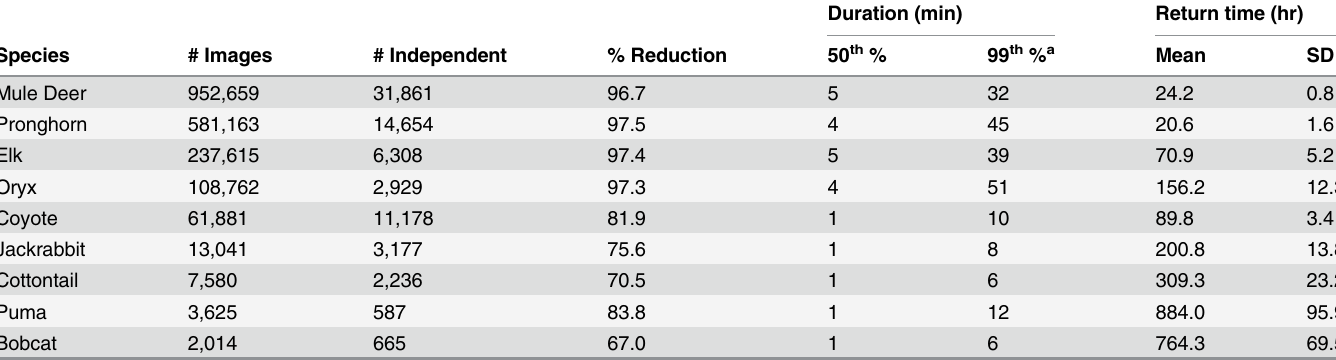
Table 1. Summary Statistics for Camera Imagery with Visit Durations and Species Return Times at Water